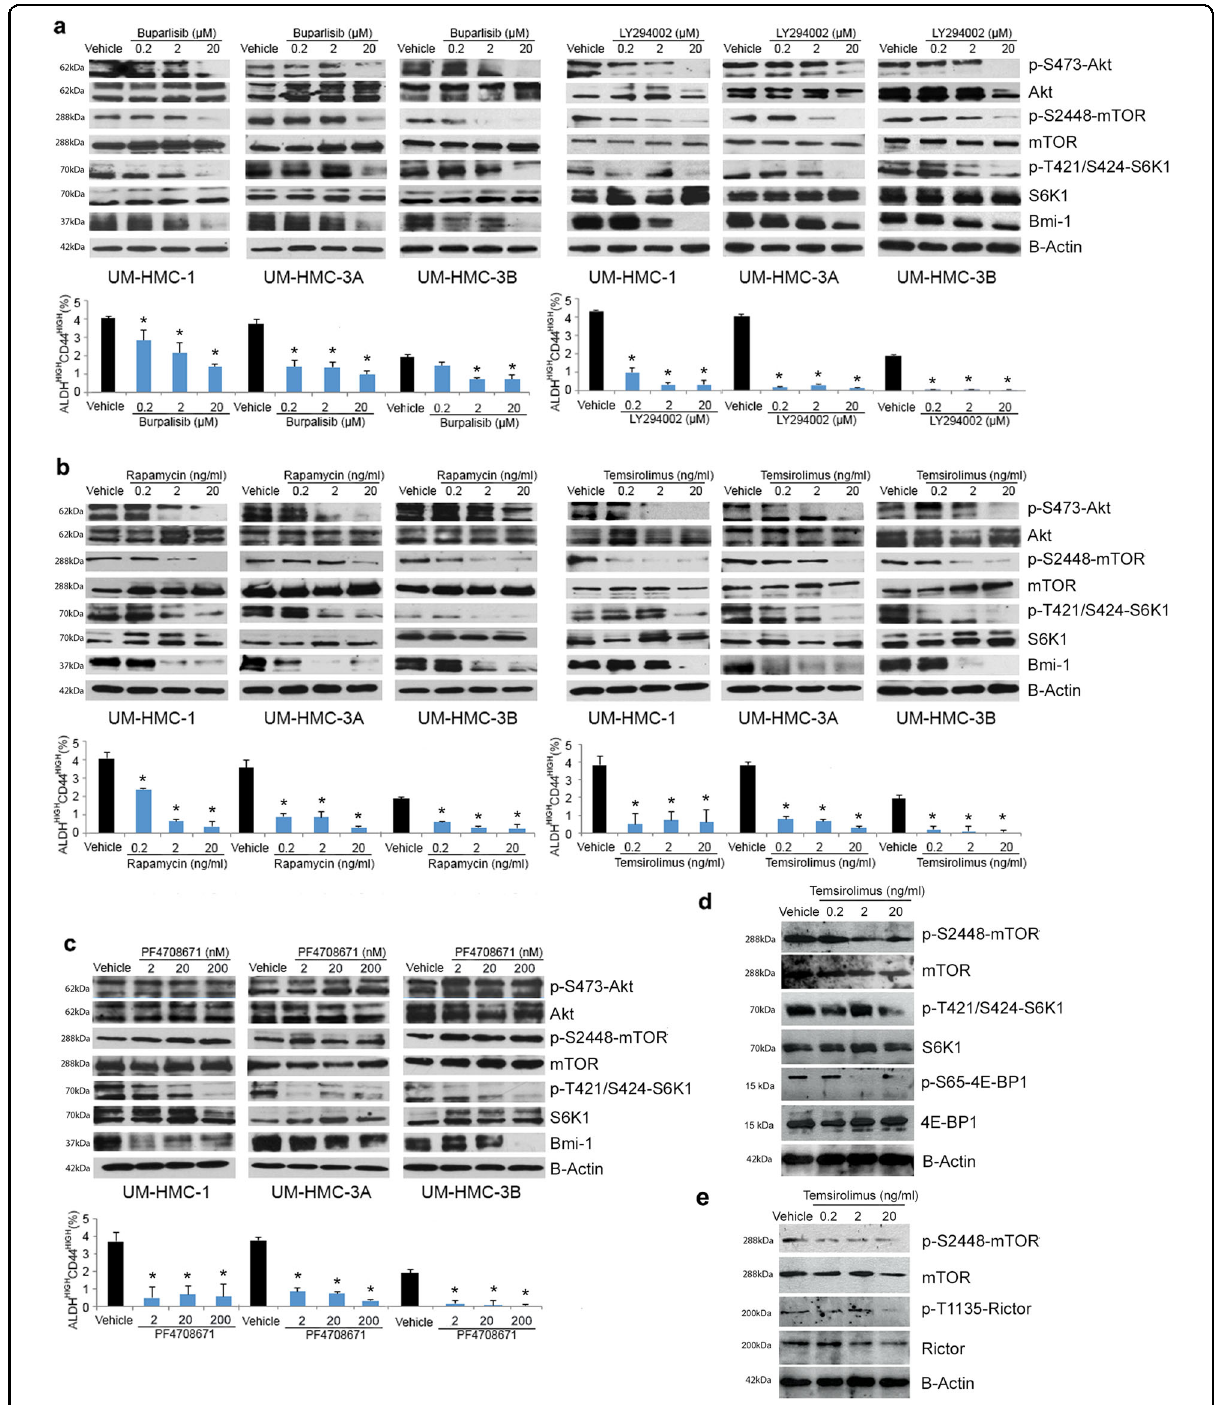
Fig. 2 (See legend on next